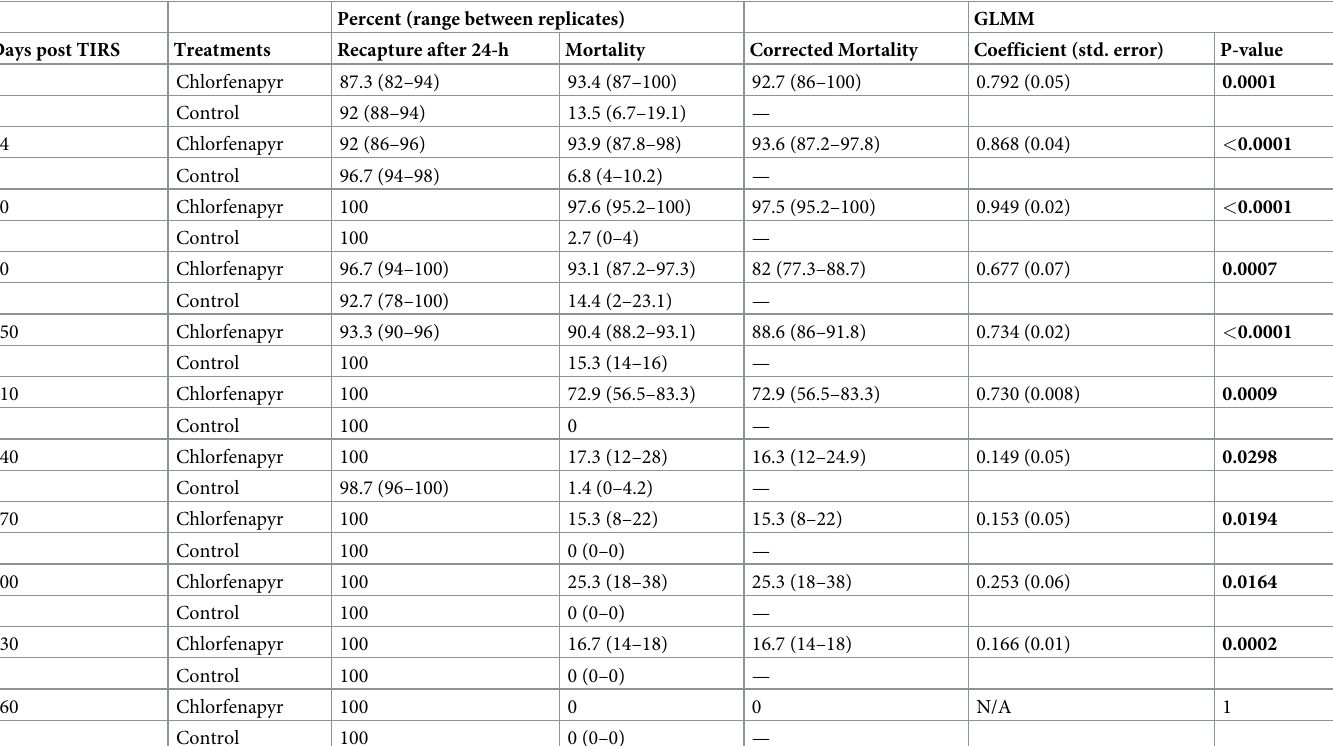
Table 2. Average (min-max) raw acute (24-h) mortality data and Abbott- corrected mortality throughout the 11 sample periods (24 hours, 2 weeks, 1, 2, 5, 7, 8, 9, 10, 11 and 12 months) and results from a Generalized Linear Mixed Model (GLMM) quantifying the significance in mortality between control and treatment mea- sures (control used as